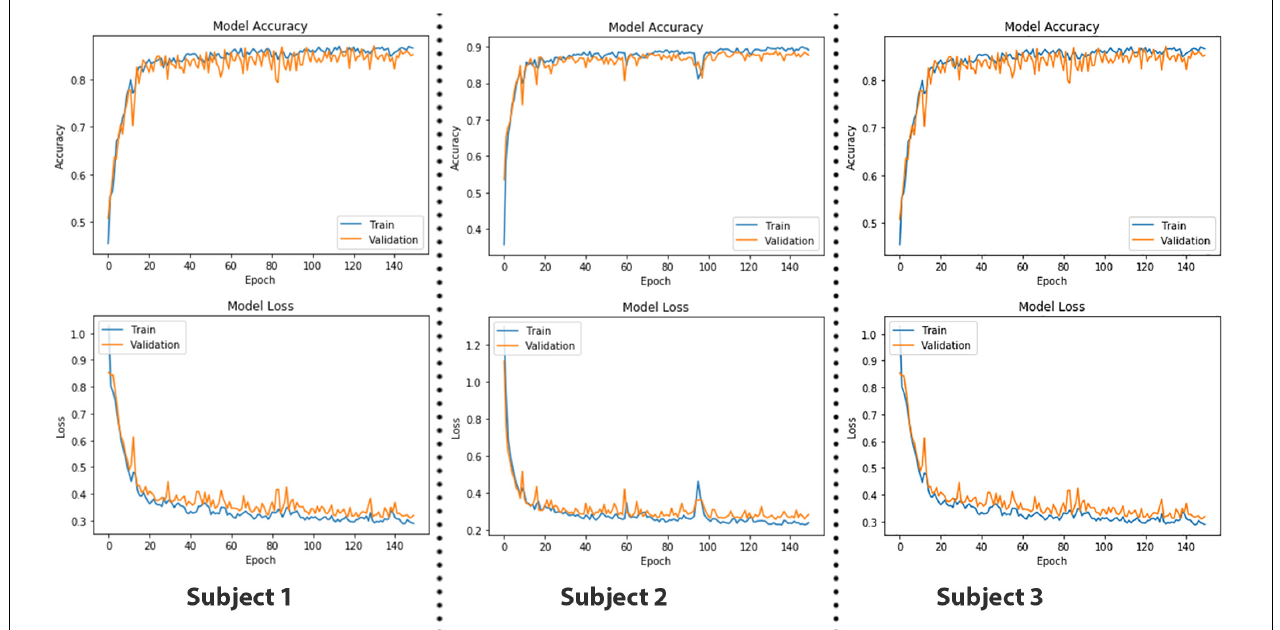
FIGURE 8 | The epoch versus accuracy and loss plots of convolutional neural network (CNN) model on train and validation datasets. Accuracy increases with number of epochs and then saturates; vice versa for the